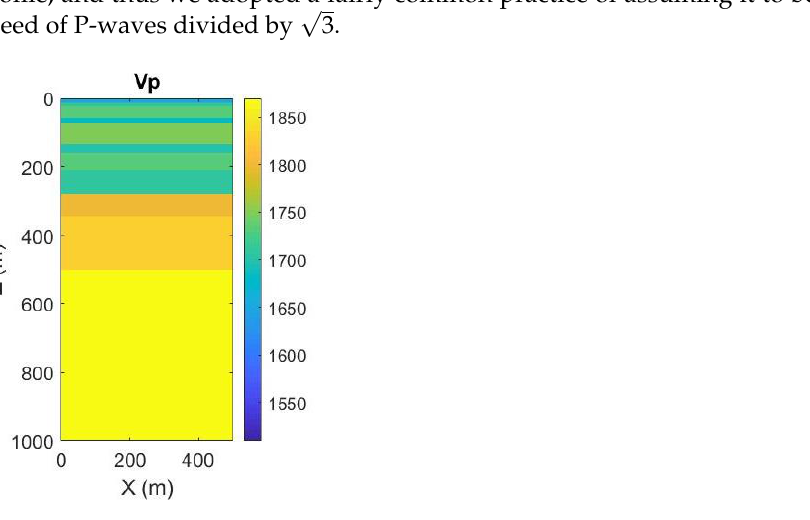
Figure 4. P-wave velocities along one of the vertical wells in the study